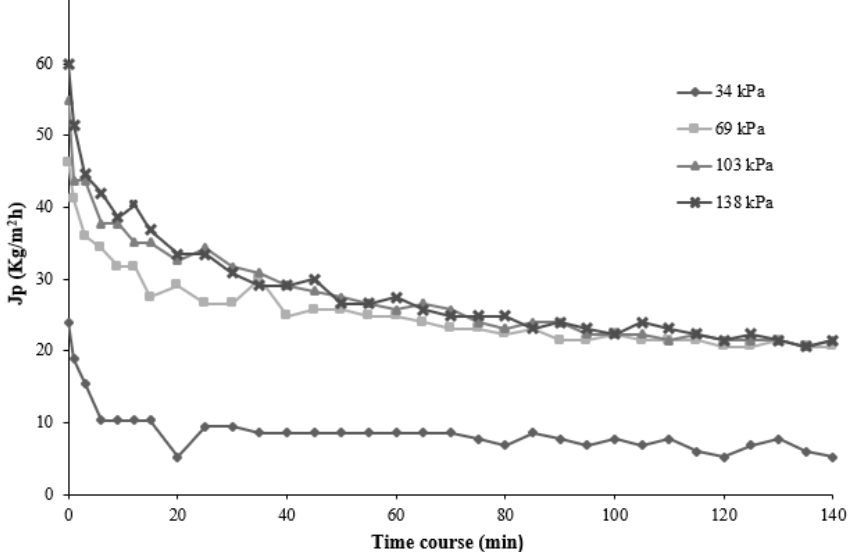
Figure 2. Permeate flux as a function of operating time at different transmembrane pressures (Operating conditions: T = 21 °C, Qf = 77.8 L/h).